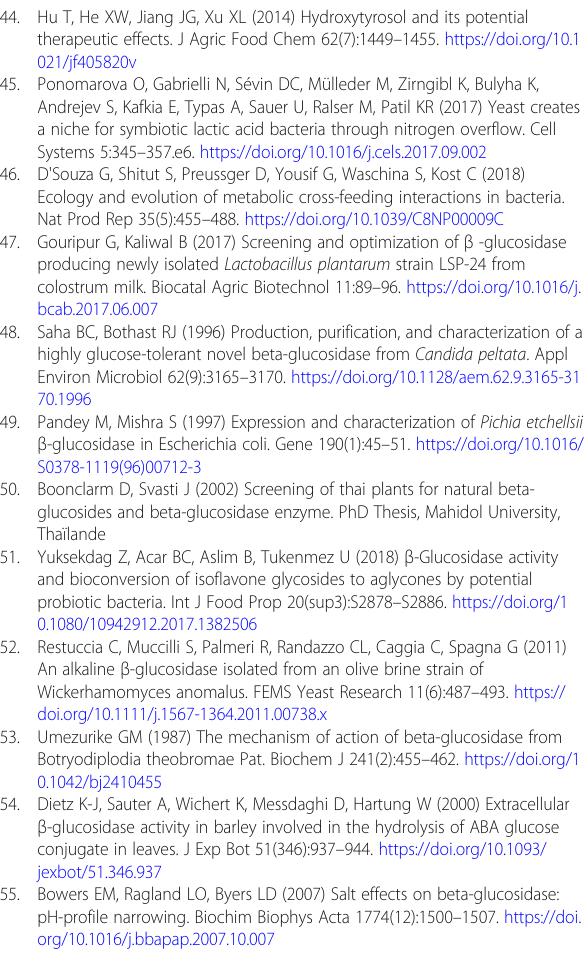
Italian table olives. LWT - Food Sci Technol 57(2):710 – 717. https://doi.org/1